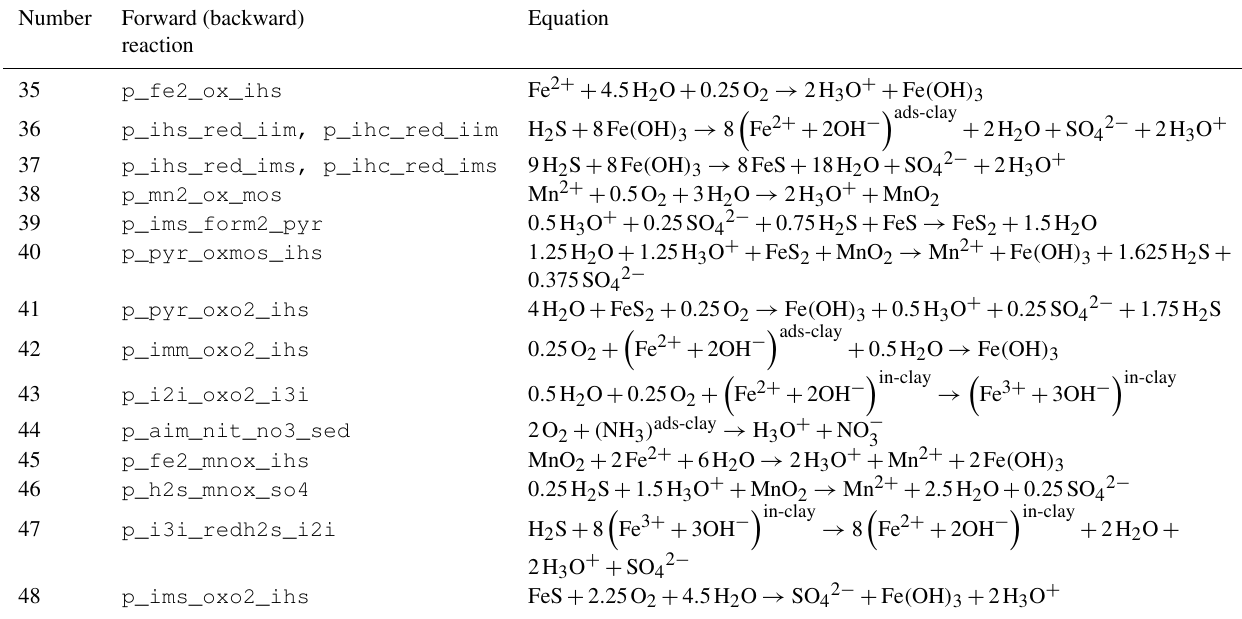
Table 4. Reaction network table for the secondary redox reactions in the sediment and in the fluff